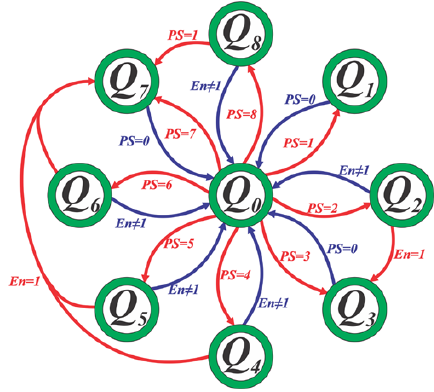
Figure 7. Diagram of the “P” state machine. Table 5. Description of the “P” state machine. State Description